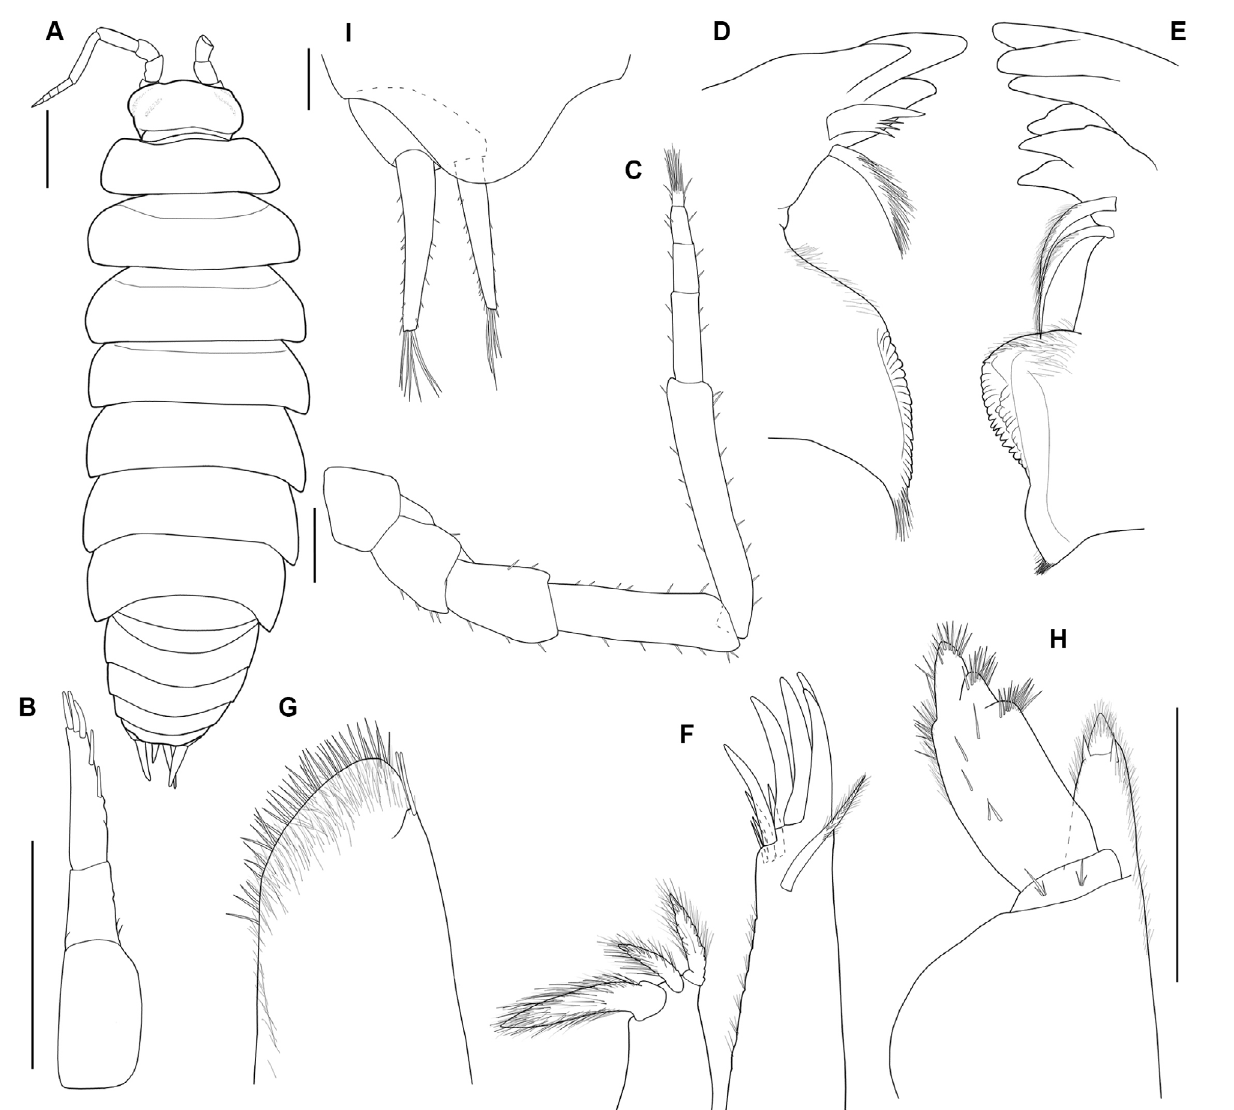
Figure 6. Spelunconiscus septemlacuum sp. nov. A : Habitus; B : antennule, C : antenna; D : right mandible; E : left mandible; F : maxillule; G : maxilla; H : maxilliped; I : pleotelson and uropod. Scale bar: 0.2